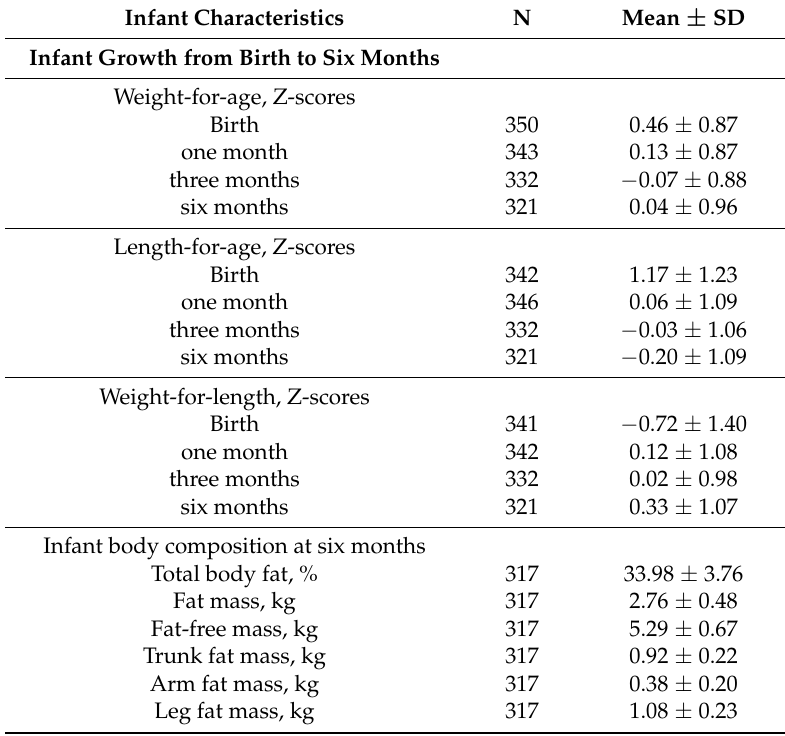
Table 2. Average infant growth measures from birth to six months and body composition measures at six months.